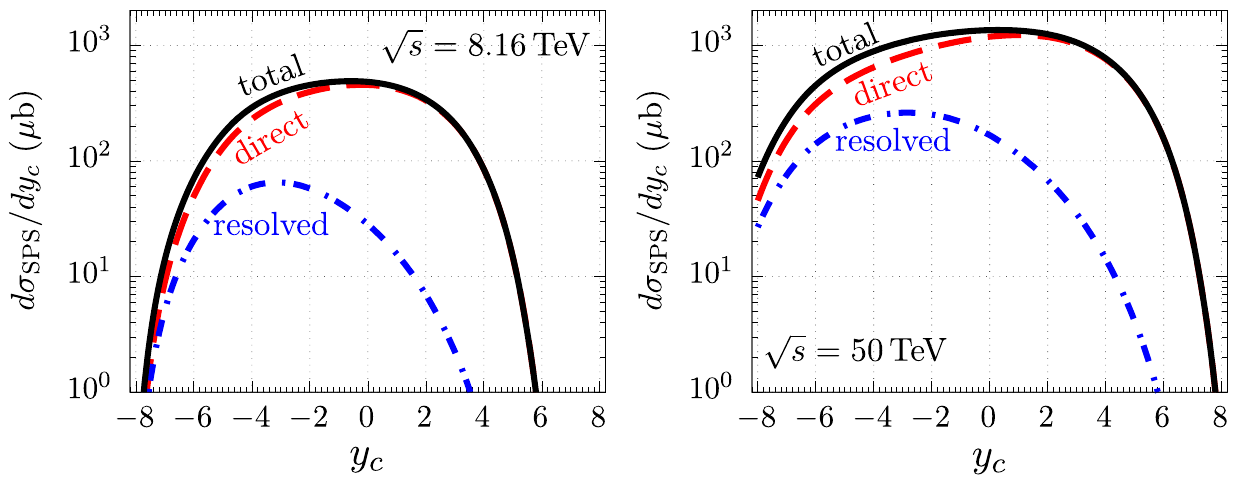
√ s = 8 . 16TeV is shown in the left panel